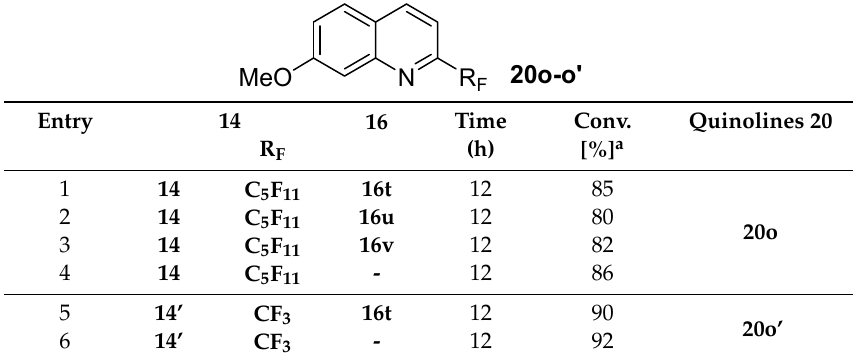
Table 4. Reaction conditions and conversions obtained for the formation of substituted 2-perfluoropentyl-/2-trifluoromethyl-7-methoxyquinolines ( 20o – o’ ), starting from m -anisidine 15o , with or without ketone 16t – v .